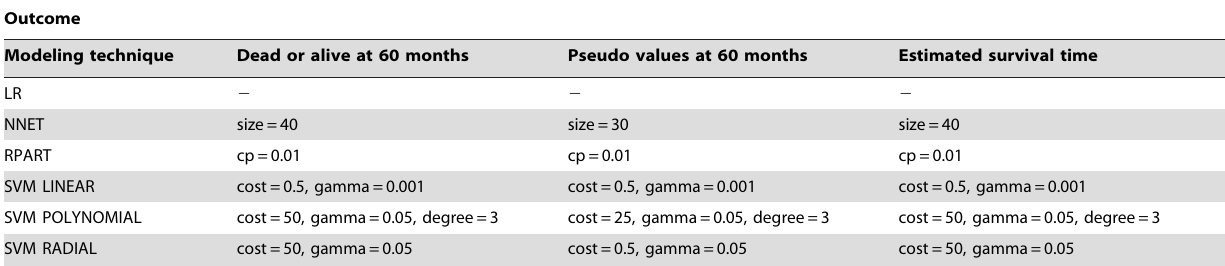
Table 6. Mode of the parameter settings identified as optimal in bootstrap samples.